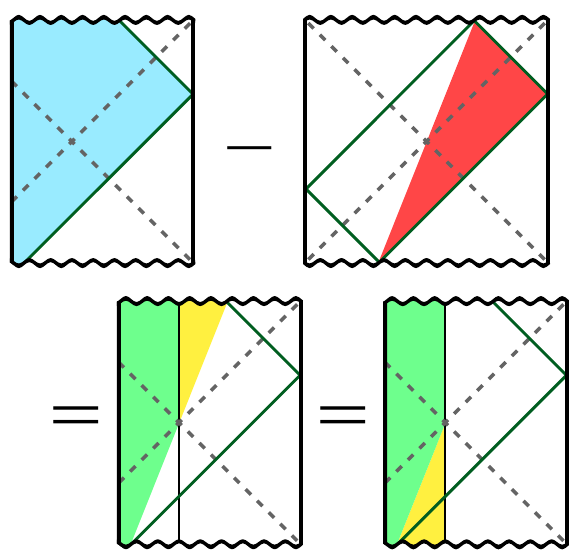
Figure 26 . The geometric argument for why the complexity is constant during phase ii. The half TFD Wheeler-DeWitt patch (red) is subtracted from the phase ii patch (blue). The remaining region is broken into two pieces (green and yellow) that are rearranged to become the entire region behind the horizon. This \proof" is independent of boundary